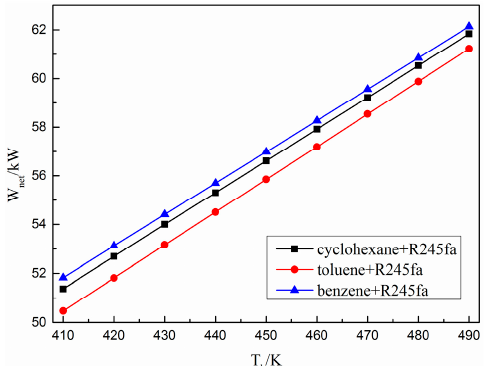
Figure 8 . Effect of T b on total heat absorption of high and low temperature cycle evaporators.